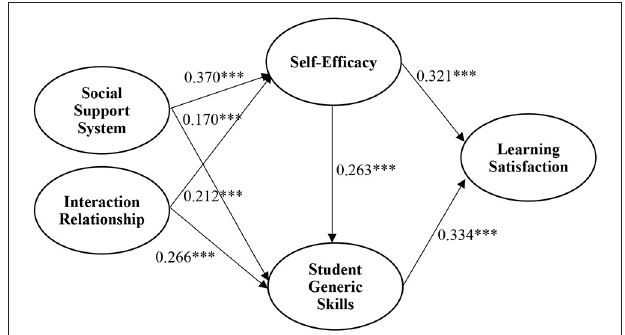
FIGURE 2 | Structural model. *** p <